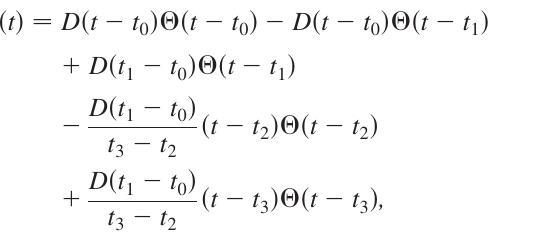
ð¼ (cid:1) 800 (cid:5) s Þ , flattop time t 0